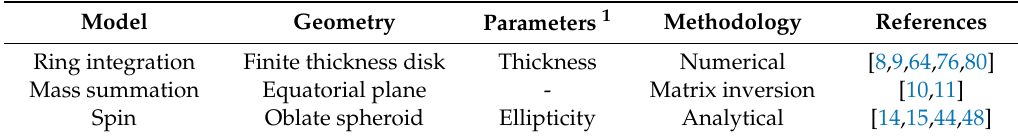
Table 3. Newtonian Inverse Models Applied to Rotation